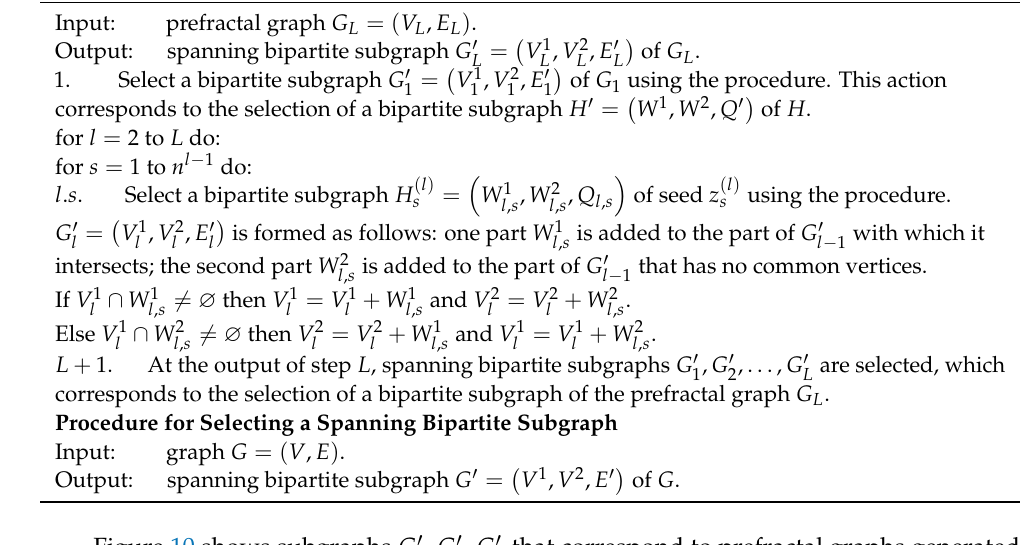
Algorithm 3 Algorithm for Packing a Bipartite